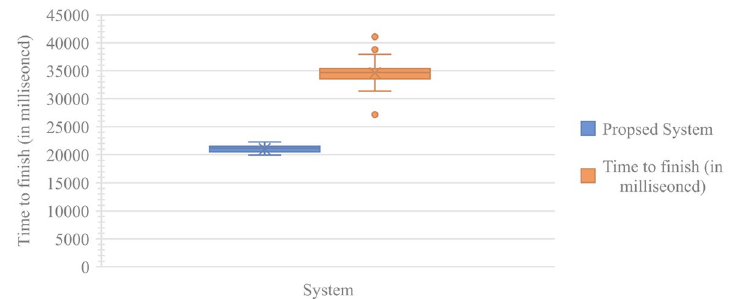
Fig. 10 Box plot chart of database read evaluation